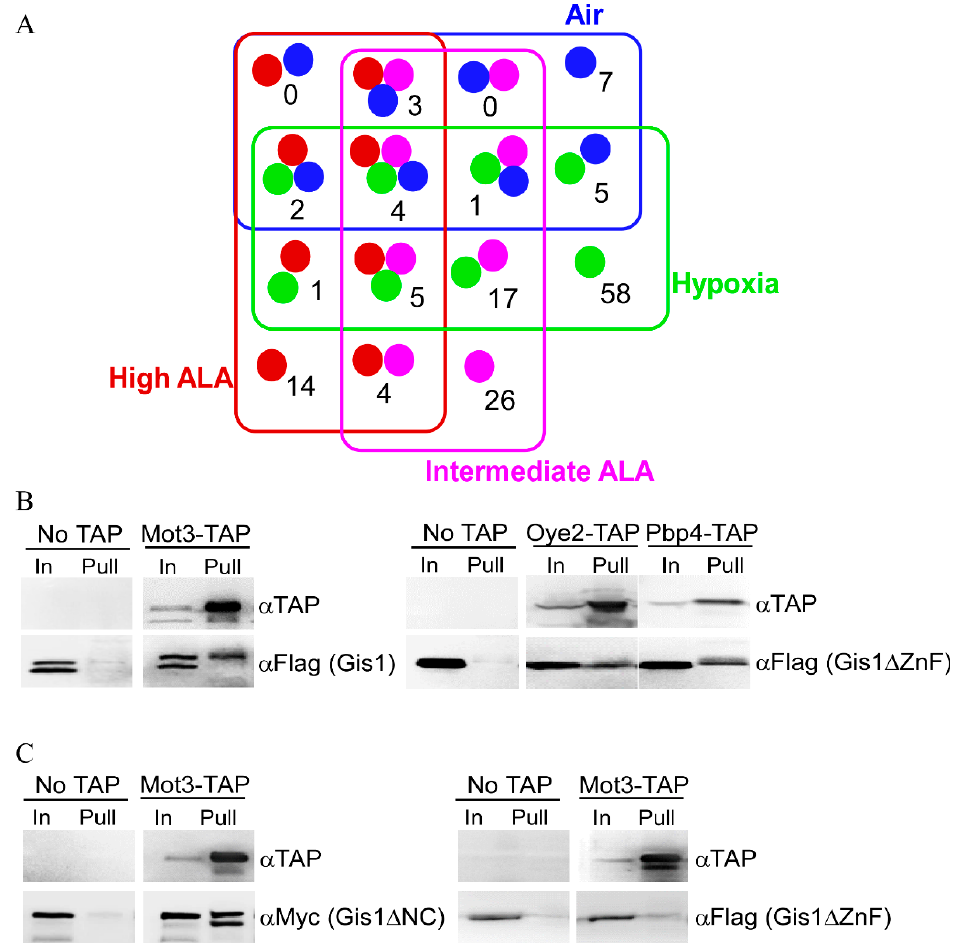
Figure 6. ( A ) Venn diagrams showing overlaps for Gis1-bound proteins under various conditions. The numbers of proteins bound to Gis1 identified from extracts prepared from cells grown under various conditions are shown here. ( B ) TAP pull-down confirms that Mot3, Oye2, and Pbp4 interact with Gis1. Extracts prepared from cells expressing TAP-tagged Mot3, Pbp4, or Oye2 and FLAG-tagged Gis1 were incubated with IgG-Sepharose 6 beads. Input proteins (In) and pulled-down (Pull) proteins were electrophoresed and detected by anti-TAP or anti-FLAG antibodies. Blots were probed with anti-TAP antibodies and then stripped and probed with anti-Flag antibodies. ( C ) The Gis1 ZnF domain, but not the JmjN/C domain, is required for interaction with Mot3. Extracts prepared from cells expressing TAP-tagged Mot3 and FLAG-tagged Gis1 Δ ZnF or Myc-tagged Gis1 Δ NC were incubated with gG-Sepharose 6 beads. Input proteins (In) and pulled-down (Pull) proteins were electrophoresed and detected by anti-TAP, anti-Myc, or anti-FLAG antibodies. Blots were probed with anti-TAP antibodies and then stripped and probed with anti-Flag or anti-Myc antibodies. Table 1. List of bound proteins found only in extracts from hypoxic cells.